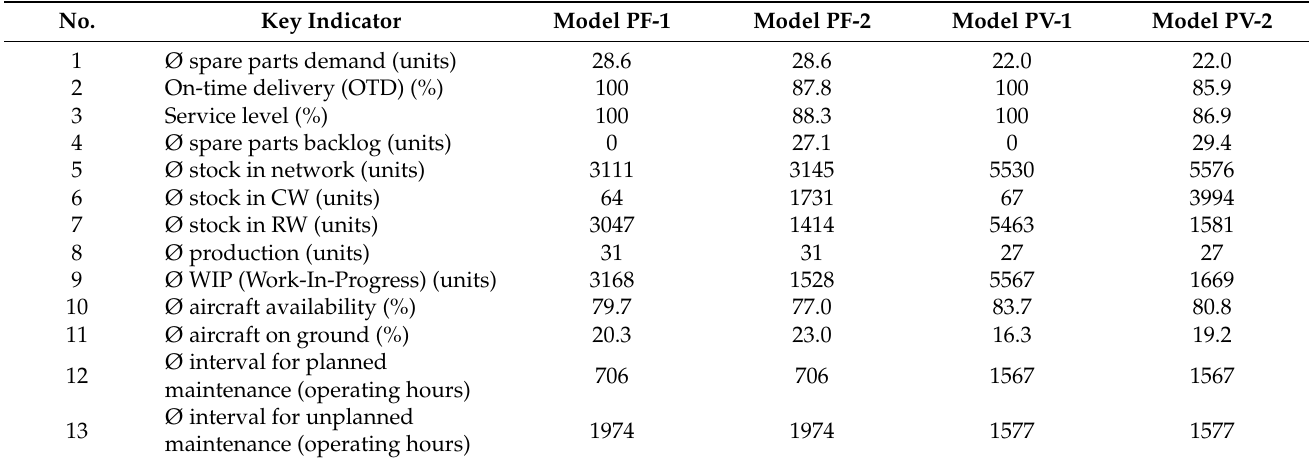
Table 3. Simulation results for the second demand scenario—low demand for spare